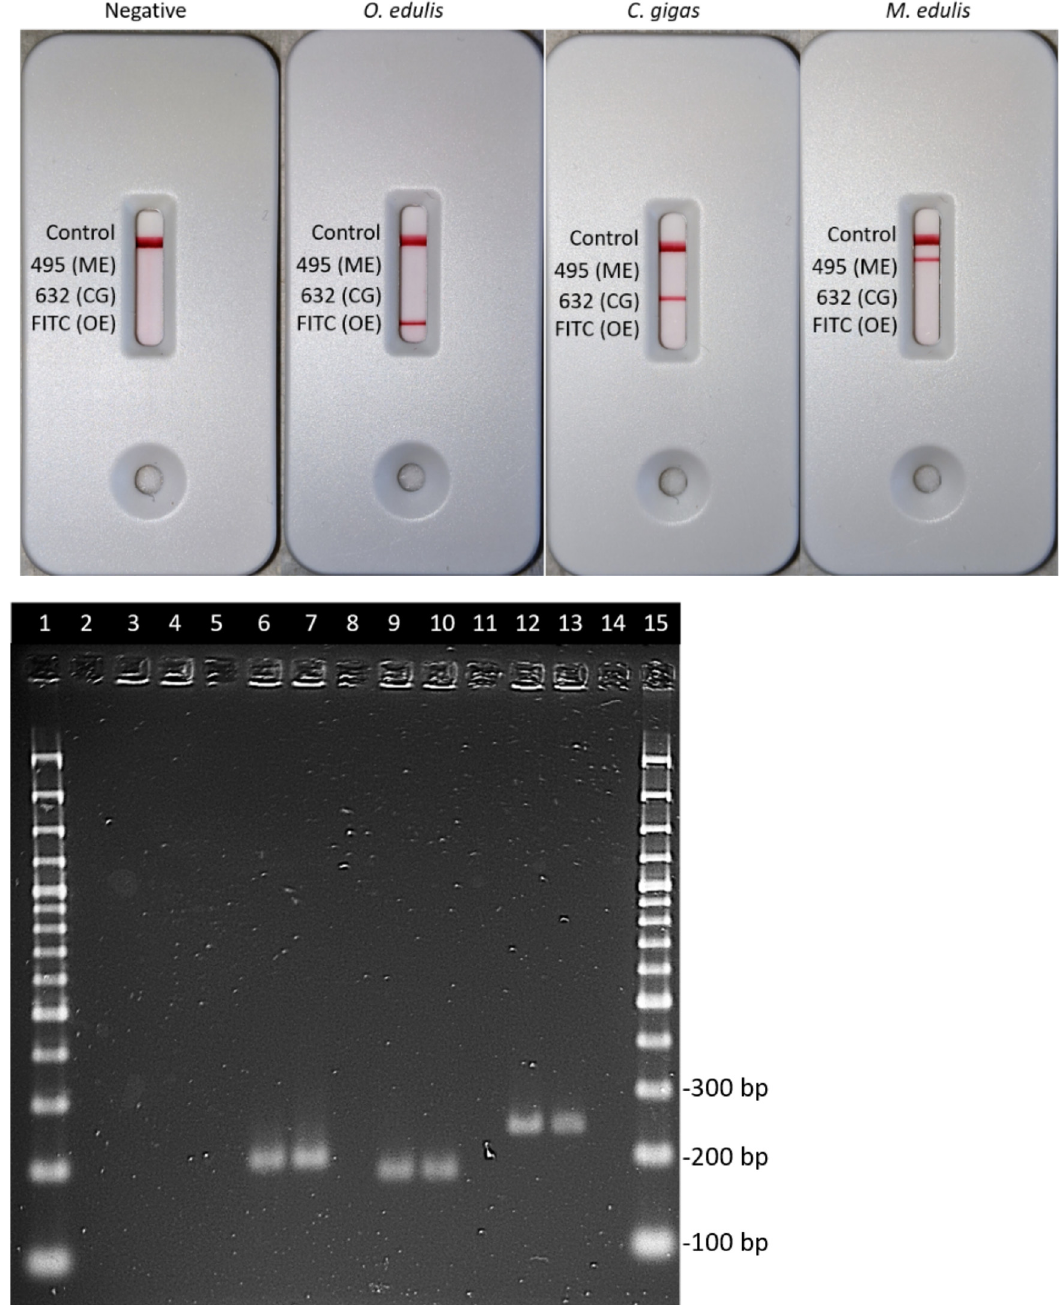
Fig. 4. PCR-nucleic acid lateral fl ow immunoassay (NALFIA) with a combination of three primer pairs and one DNA template of Ostrea edulis , Crassostrea gigas , and Mytilus edulis . The label on the left side of every pair of cartridges is indicating the test line for the existence of O. edulis (FITC OE), C. gigas (632 CG), and M. edulis (495 ME). The most upper line on the cartridges is indicating the control line of each NALFIA. The image of the 3% agarose gel electrophoresis is showing the quality control of the PCR products. The scheme of the gel slots: 1: 100 bp marker, 2: empty, 3: OE / CG / ME x non-template replicate 1, 4: OE / CG / ME x non-template replicate 2, 5: empty, 6: OE / CG / ME x O. edulis replicate 1, 7: OE / CG / ME x O. edulis replicate 2, 8: empty, 9: OE / CG / ME x C. gigas replicate 1, 10: OE / CG / ME x C. gigas replicate 2, 11: empty, 12: OE / CG / ME x M. edulis replicate 1, 13: OE / CG / ME x M. edulis replicate 2, 14: empty, 15: 100 bp marker.